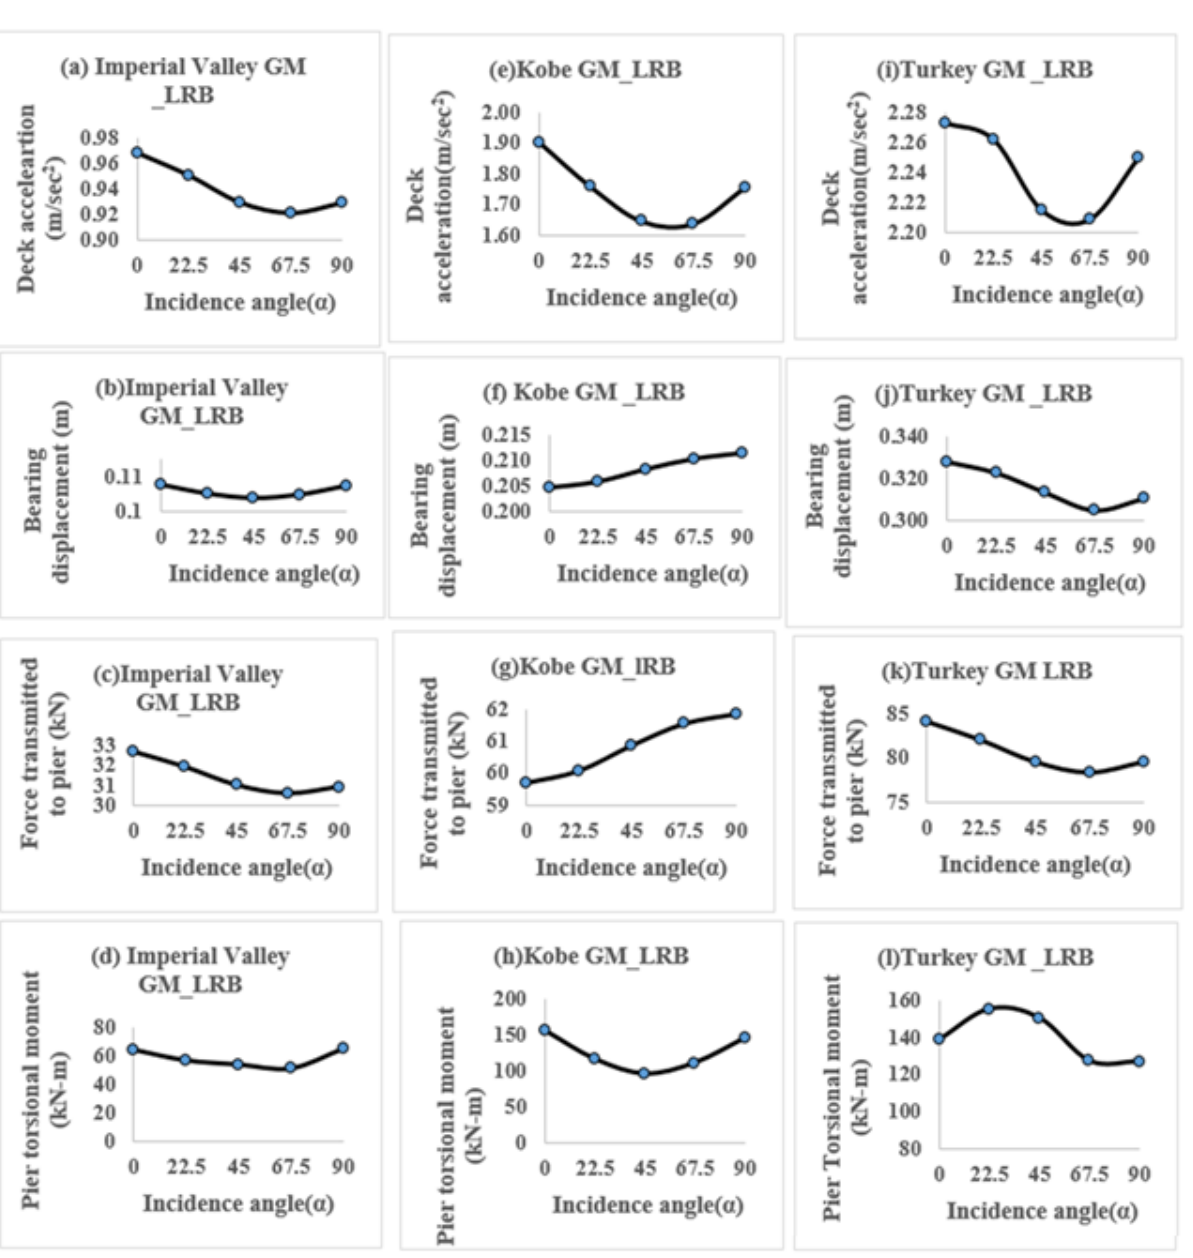
Figure 7. The bridge responses for uni-directional Imperial Valley ( a – d ), Kobe ( e – h ), and Turkey ( i – l ) Ground Motions with the variation of incidence